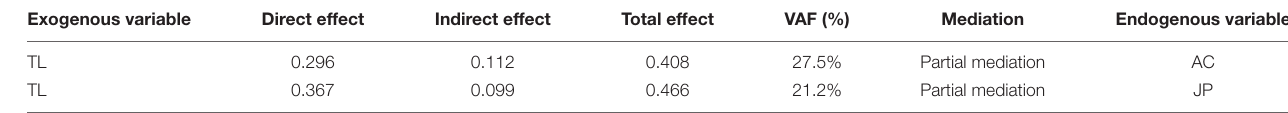
TABLE 6 | Mediation analysis (employee engagement as a